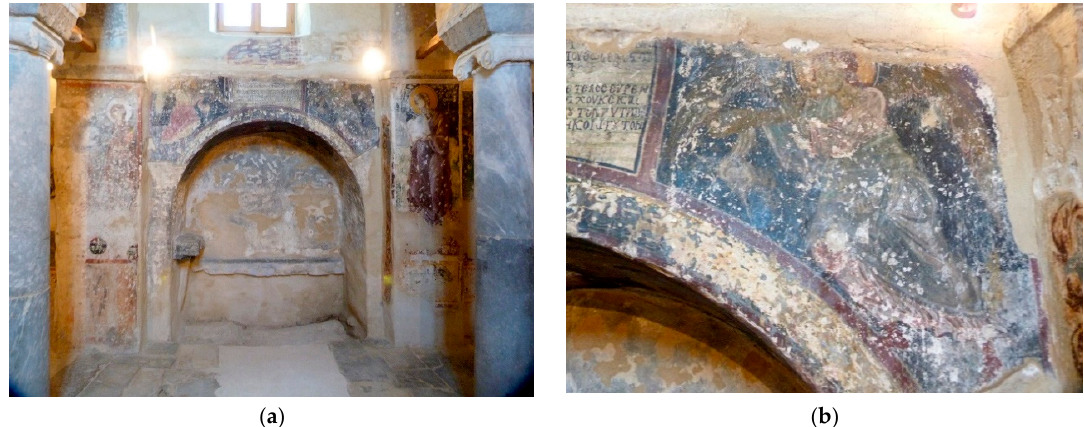
Figure 14. Hagios Georgios in Akraifnio (Karditsa, Boeotia, Greece). ( a ) Arcosolium with painted inscription (1311), south of the crossing; ( b ) angels blowing trumpets, right spandrel of the arcosolium. © Author with the permission of the Ephorate of Antiquities of Boeotia.